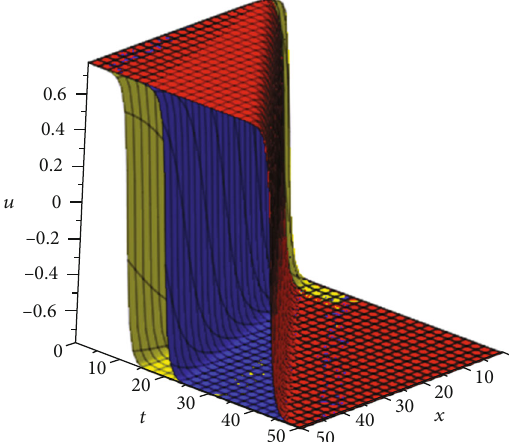
Figure 3: 3D plot of solution (27) for various values of β , and k = 1, ρ = 2, c = − 1 : 2, C 4 = C 5 = 1 .